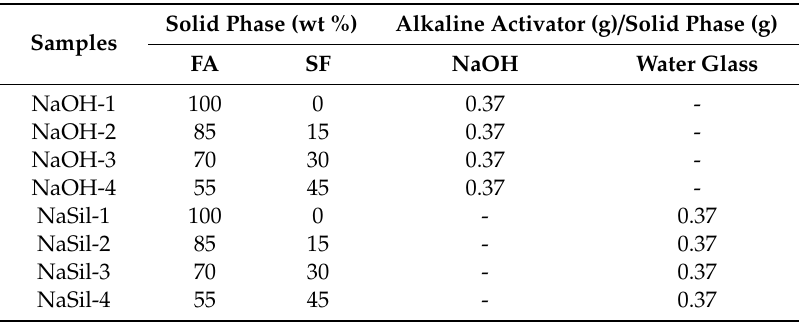
Table 2. Proportioning design of the fly ash (FA)-based